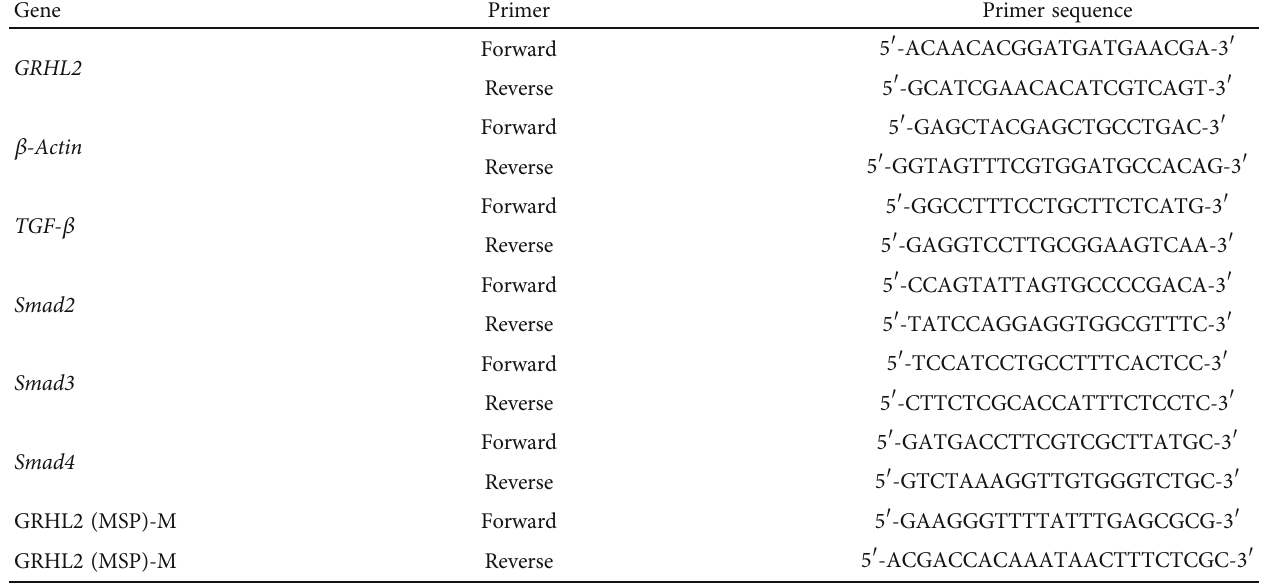
Table 2: The primers of qPCR and MSP.